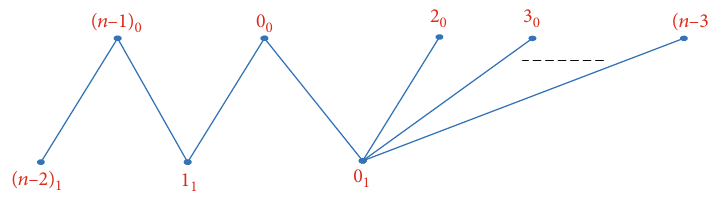
Figure 17: An orthogonal labeling for C